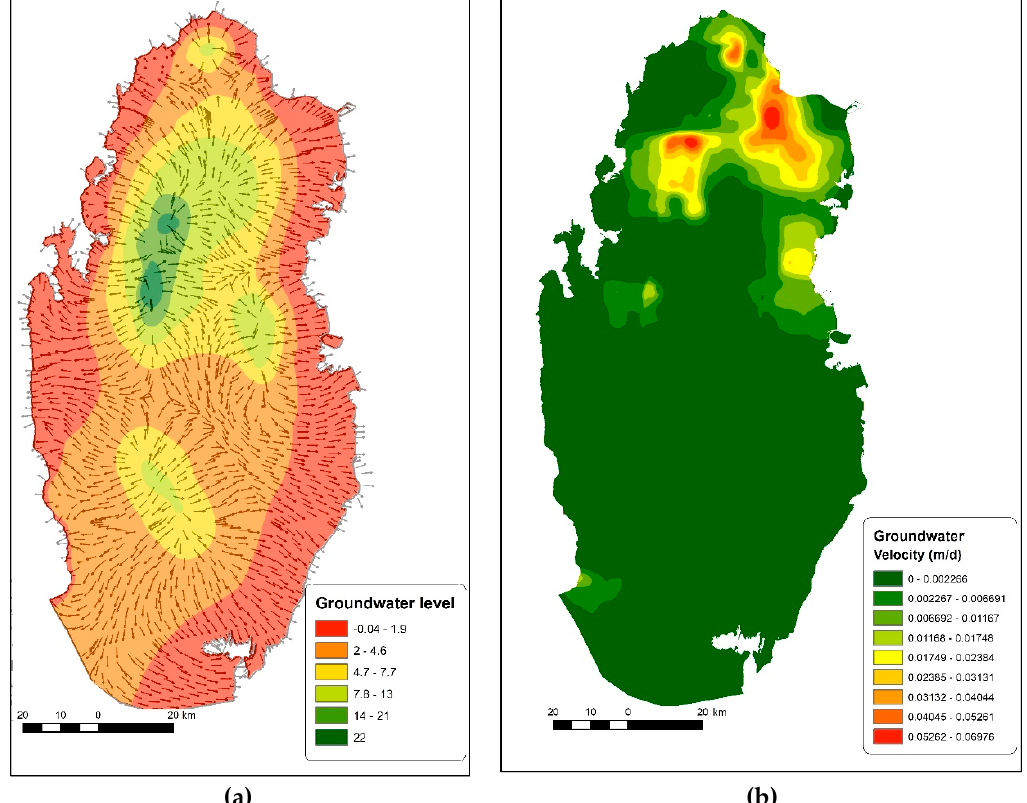
Figure 6. Simulated steady state groundwater levels (m/d), and velocity vectors ( a ) and groundwater velocity magnitude (m/d) ( b ).